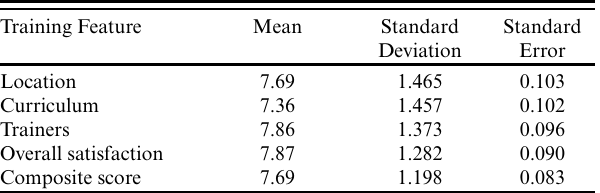
Table 3 . Prescribed Fire Training Exchange participant satisfaction ratings. †